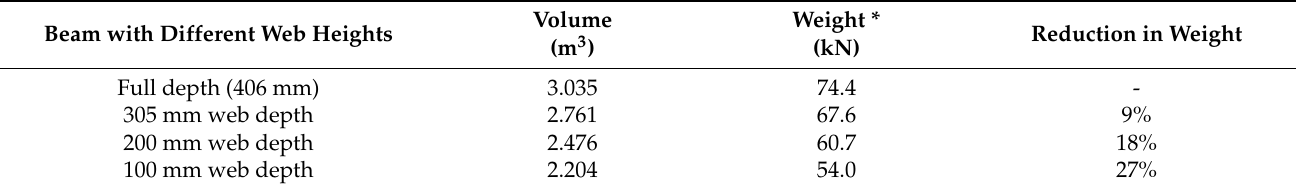
Table 4. Reduction in beam weight.